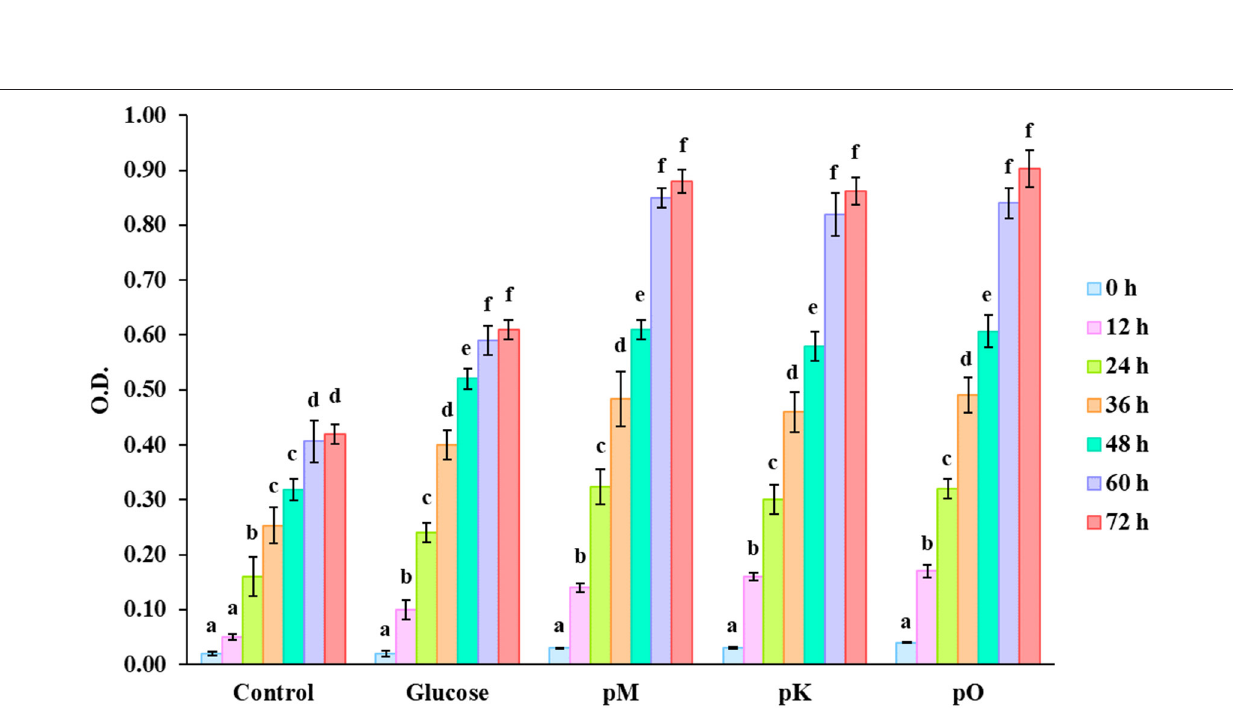
Frontiers in Nutrition |